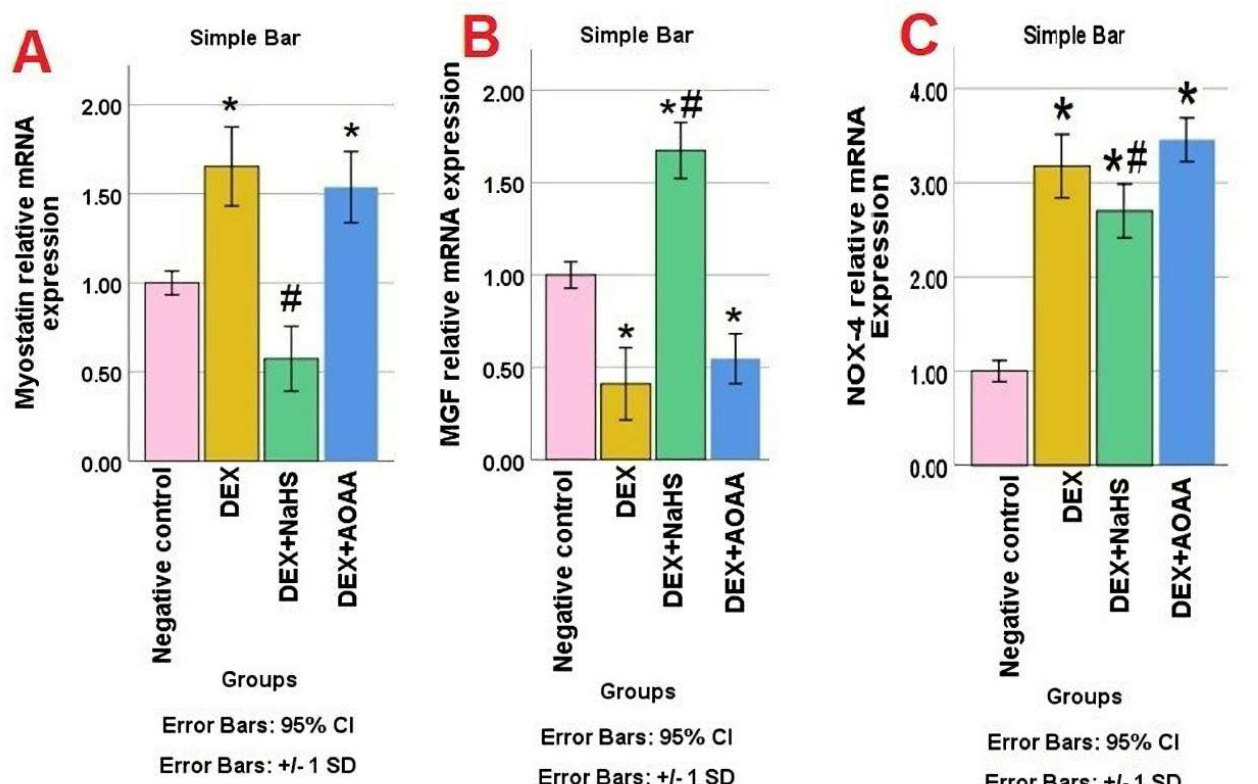
Figure 2. Expression levels of Myostatin ( A ), MGF ( B ), and NOX-4 ( C ) in all studied groups. Data are expressed as mean ± SD, the test used: one-way ANOVA, followed by post-hoc Tukey test (normalized by GAPDH, products of RT-PCR). Dex: Dexamethasone, NaHS: Sodium hydrosulfide and AOAA: Aminooxyacetic acid. p : significance (<0.05). *: significance as compared to the control ( C ) group. #: significance as compared to (Dex)